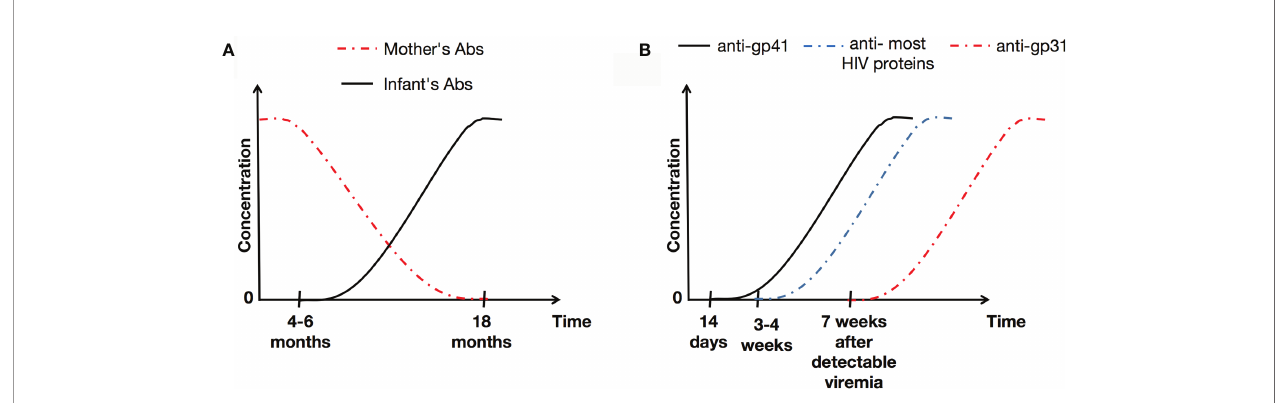
FIGURE 1 | Illustration of HIV-1-speci fi c antibody concentrations over the time in infants (A) and the general population (B) . Abs,